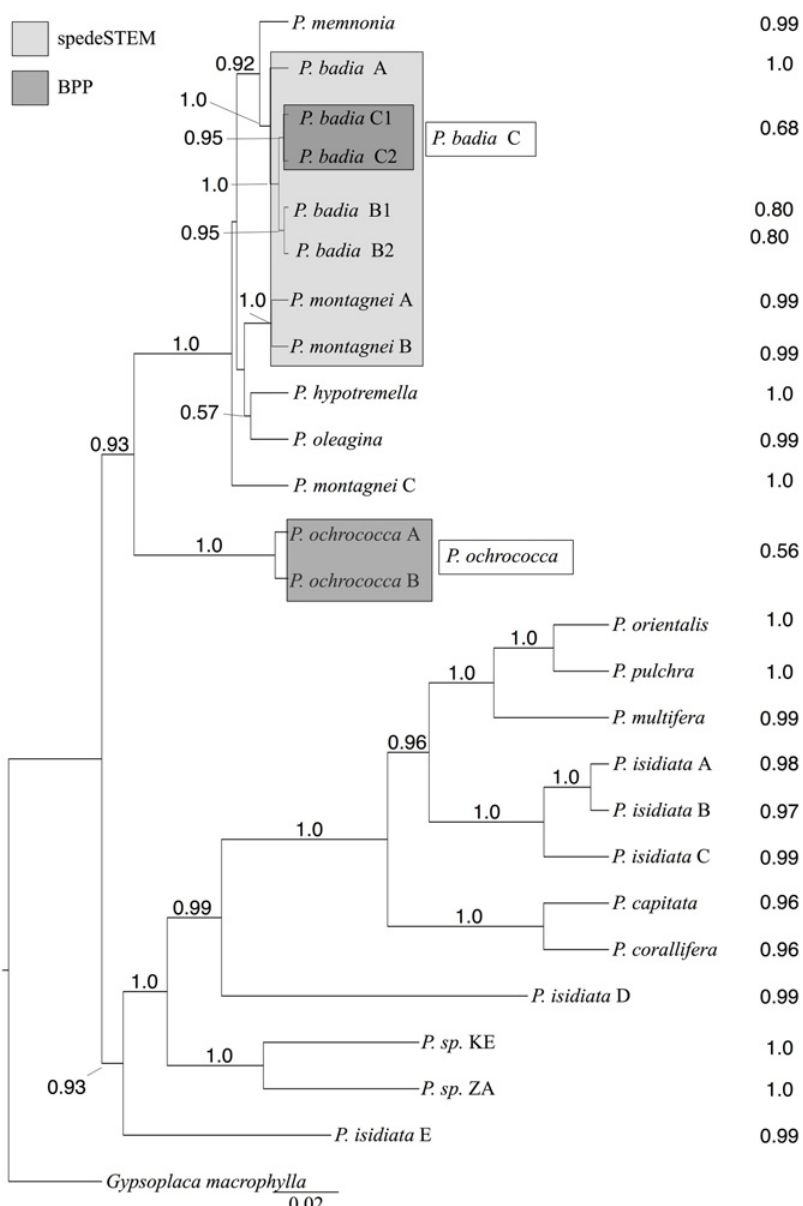
Fig 3. * BEAST species trees for Protoparmelia s . str . as suggested by ML (BS (cid:1) 70%) or Bayesian (PP (cid:1) 0.94). Posterior probabilities at nodes indicate support from the * BEAST analyses. The posterior probability of each delimited species calculated by BP&P are indicated in front of each putative species. Boxes in dark grey indicate clades not supported as separate taxa by BP&P. Protoparmelia badia B1 & B2 were supported as separate species whereas P . badia C1 & C2 were not supported as separate species (referred to as P . badia C) by BP&P. Box in light grey indicates species not supported as separate taxa by